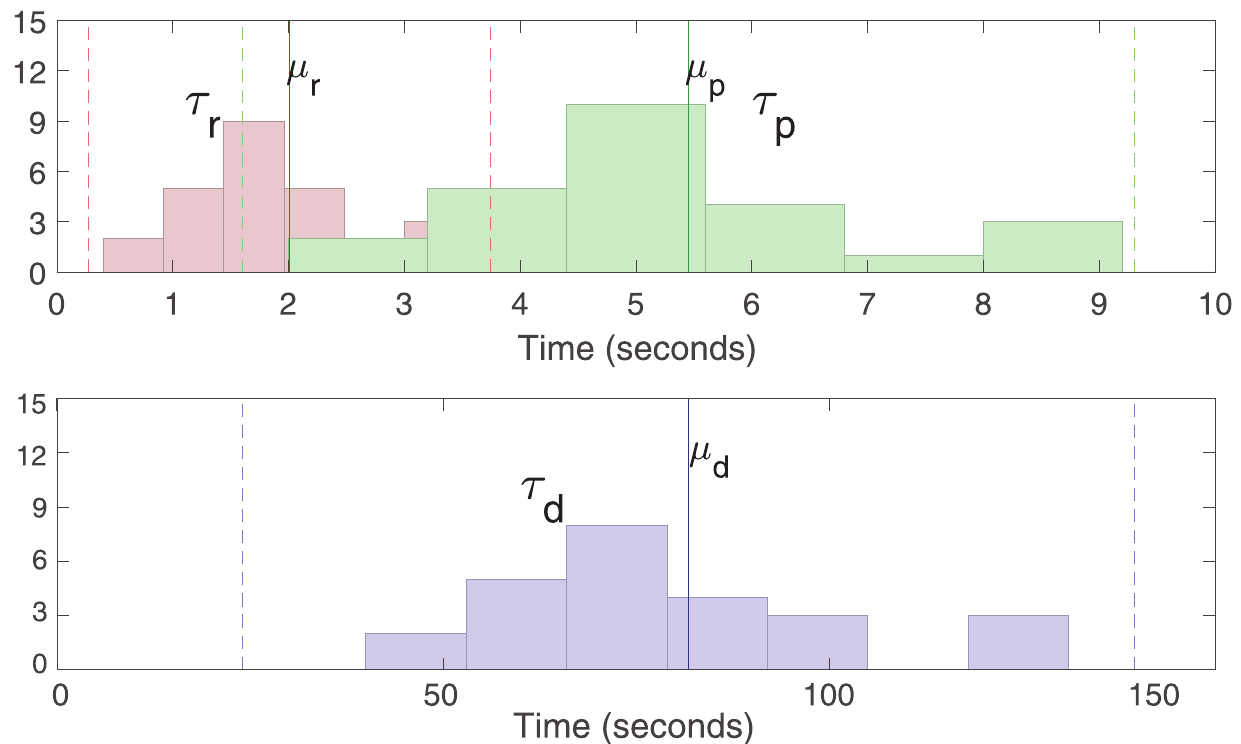
Fig 3. Histograms of estimated SCR shape parameters using our approach. In top sub-panel in the red and green bar plots correspond to the histogram plots of the estimated rise time τ the corresponding histograms, respectively.